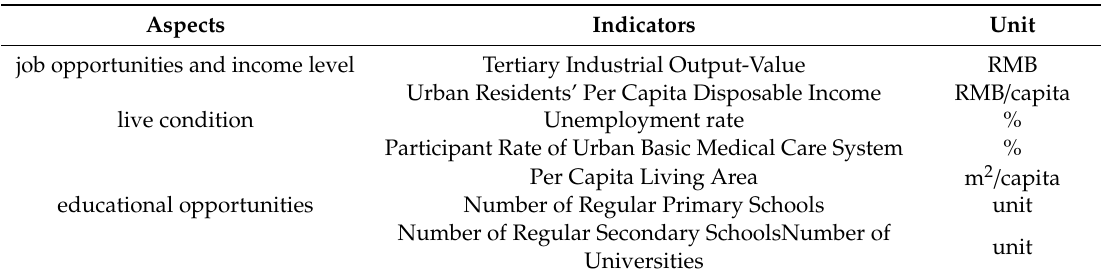
Table 3. Indicator system of urban pulling